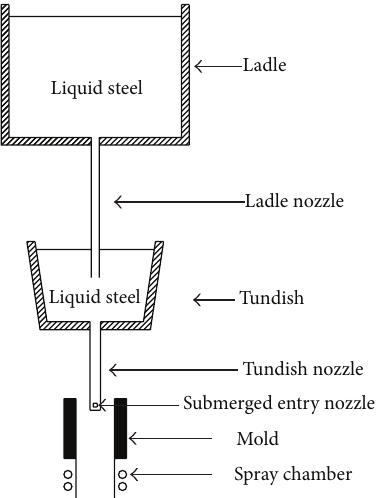
Figure 1: Schematic diagram of a continuous casting setup.